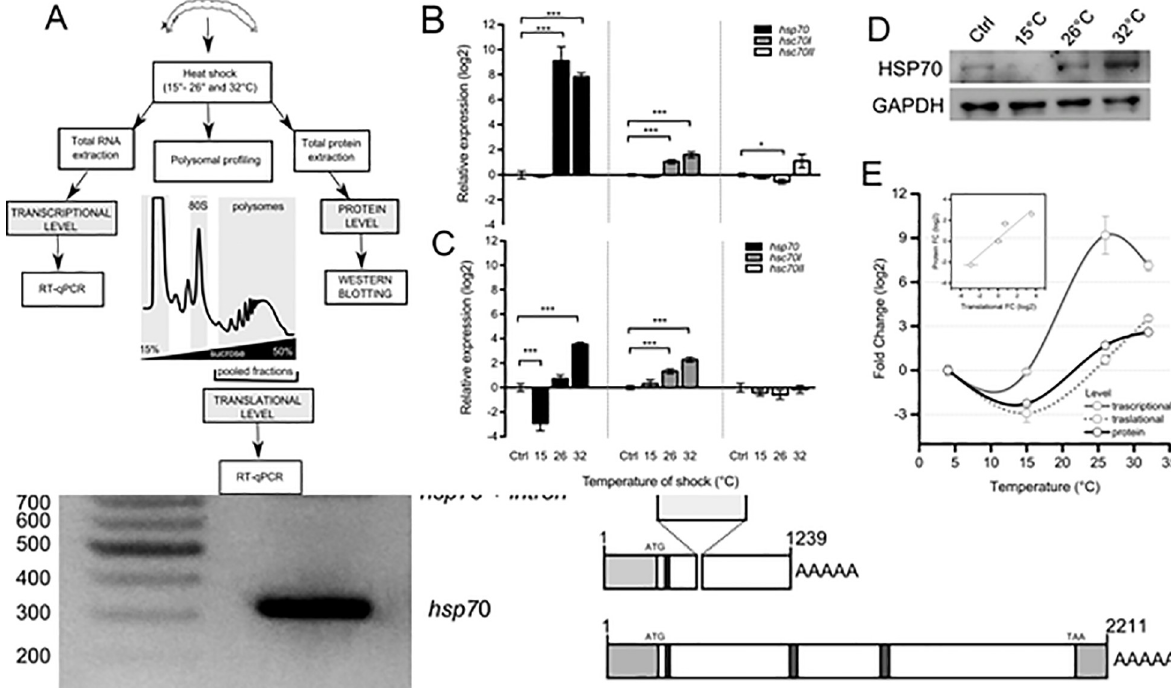
Fig 3. Multi-level analysis of gene expression of Dc - hsp70 , hsc70-I and hsc70-II during thermal stress. ( A ) Experimental design for comparing changes in gene expression at multiple levels. Insects were exposed to thermal stress. Total RNA was extracted to analyse the changes at transcriptional level. In parallel, changes associated with mRNA recruitment to polysomes was obtained by RNA extraction from polysomal fractions. These were collected after polysomal profiling to assess the translational changes in gene expression. Finally, whole proteins were extracted to assess protein level. In the first two cases, all three transcripts were studied. For the protein level, only Hsp70 was monitored. ( B ) Transcriptional expression level for hsp70 , hsc70-I and hsc70-II . Total RNA was extracted from Diamesa tonsa larvae control (Ctrl, 4˚C) or maintained for 1 h at 15, 26, and 32˚C. hsp70 , hsc70-I and hsc70-II relative expression levels were measured by real-time PCR. Actin was used as housekeeping gene and the level of control (Ctrl, 4˚C) was set at 0. Error bars represent SE; n = 3 biological replicates and each assay was performed in triplicate. ( C ) Translational expression level for hsp70 , hsc70-I and hsc70-II . Polysomal RNA was extracted from sucrose fractions corresponding to the polysomal peaks of larvae control (4˚C) or maintained for 1 h at 15, 26, and 32˚C. hsp70 , hsc70-I and hsc70-II relative expression levels were measured by real-time PCR. Actin was used as housekeeping gene and the level of control (4˚C) was set at 0. ( D ) Western blot analysis of HSP70 protein level in larvae control (Ctrl, 4˚C) or maintained for 1 h at 15, 26, and 32˚C. GAPDH was used as a loading control. ( E ) Comparison of the log 2 Fold Change with respect to Ctrl of Transcriptional, Translational and Protein level after exposure to 15, 26 and 32˚C. Asterisks indicate statistically significant differences with respect to control (Student t -test, � p � 0.05, �� p � 0.01, ��� p � 0.001). In the inset, the correlation between fold changes occurring at the translational and protein level was calculated (R 2 = 0.922). In the case of transcriptional and translational comparison, the correlation was (R 2 = 0.389), see S3A Fig.